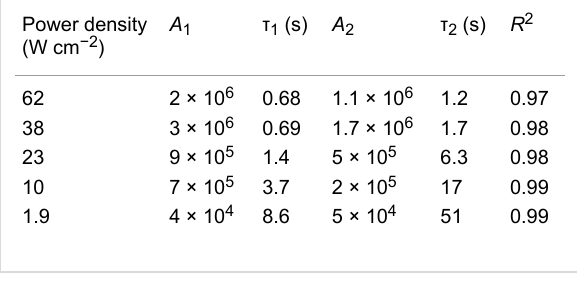
Table 1: Average fitting constants for the double-exponential bleaching curves (error bars are shown in Figure 6). Power density (W cm − 2 )